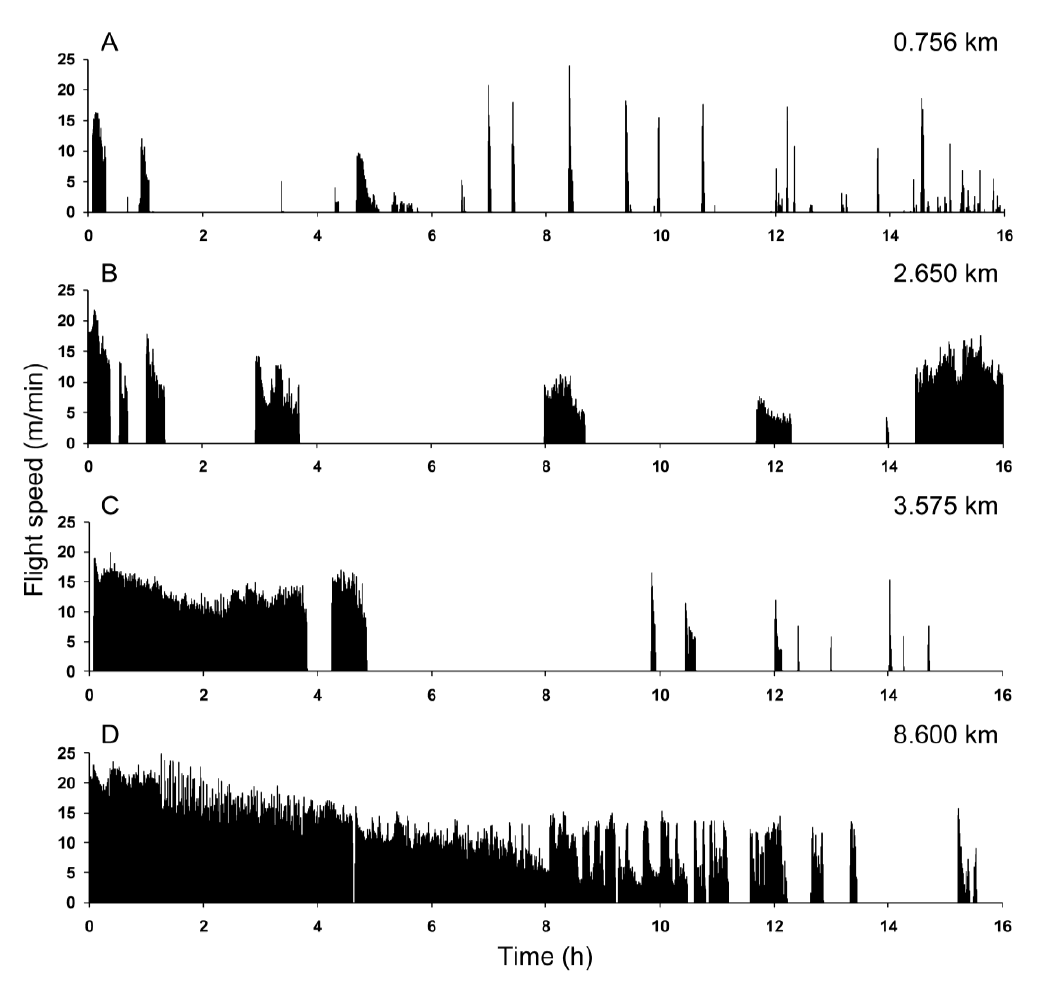
Figure 3. Representative flight profiles for individual female Ae. albopictus (3 days old) over 16 h with total distance given at the top right, and recorded flight speed given as m/min on the X axis. ( A ) Starved (access to water only), ( B ) sugar-fed (10% fructose solution), and ( C ) blood-fed immediately before the experiment (prior access to 10% fructose solution). ( D ) Exceptional flight of a blood-fed